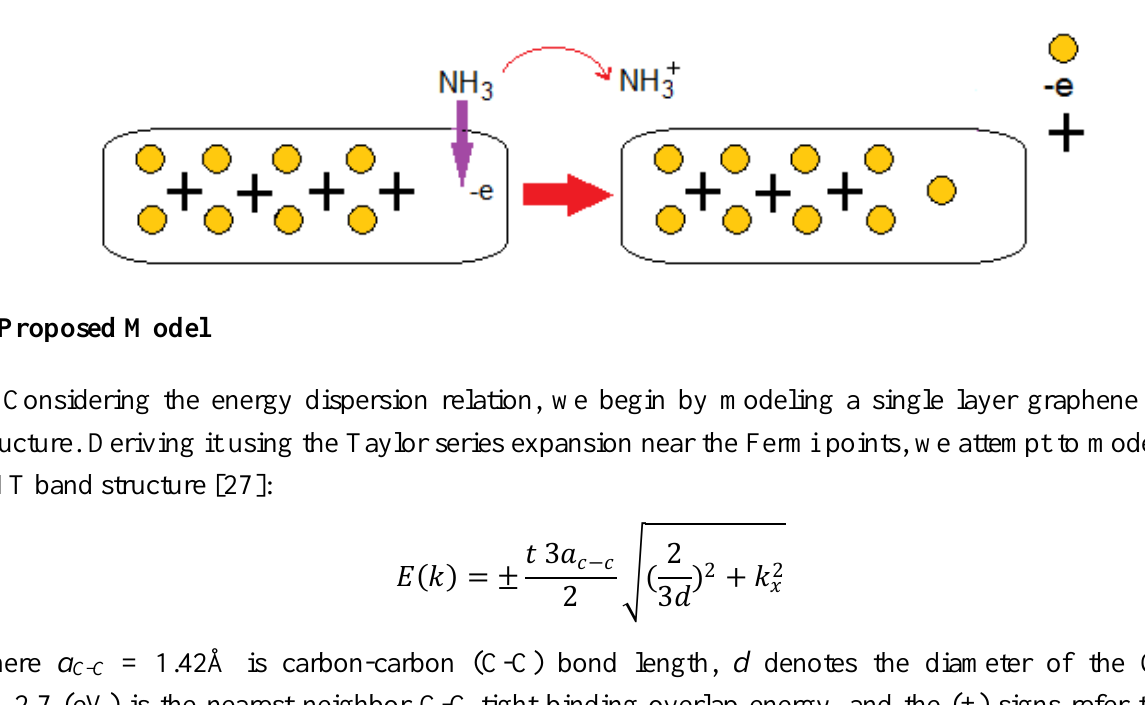
sensing mechanism employing gas adsorption phenomenon; 3 3